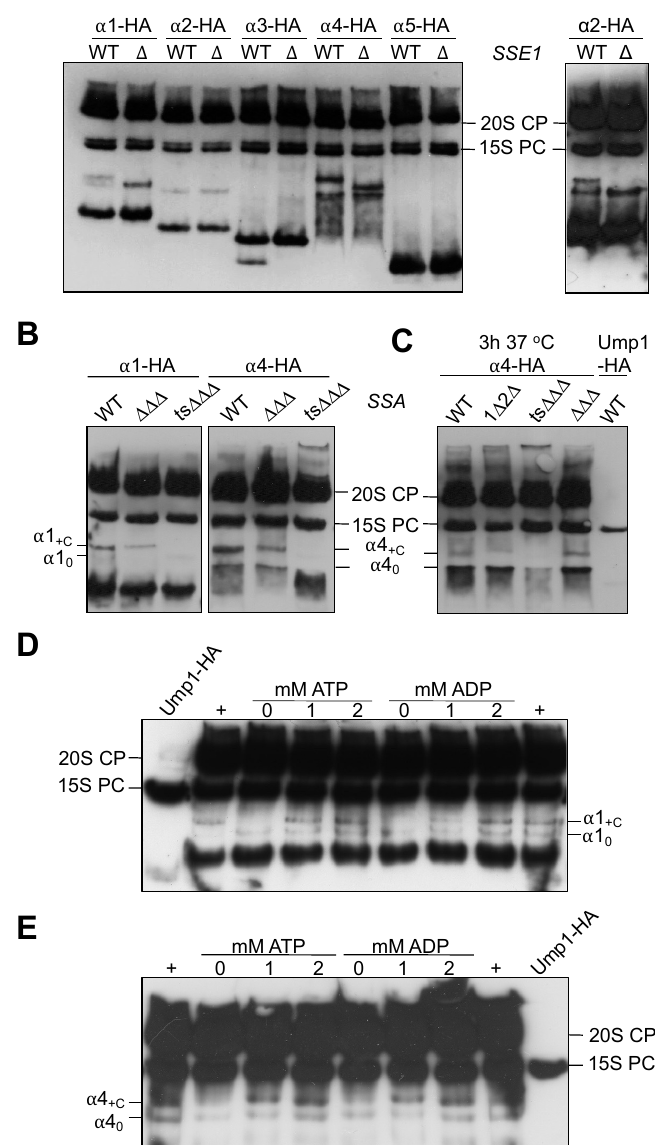
Figure 4. Effects of Hsp70 or Hsp110 mutations and ATP or ADP on early precursors complexes. ( A ) Comparison of the mobility of complexes containing a C-terminally HA-tagged version of the indicated proteasome α subunit in WT and sse1 ∆ by native PAGE. 8 μ g of total protein were loaded per lane. Right panel, analysis of 16 μ g of total protein of the indicated strains expressing α 2-HA. ( B , C ) Influence of Hsp70 mutations on α 1 and α 4 complexes analyzed by native PAGE using the following mutants: ssa1 ∆ ssa2 ∆ ( ∆ 1 ∆ 2); ssa2 ∆ ssa3 ∆ ssa4 ∆ ( ∆∆∆ ); ssa1-ts ssa2 ∆ ssa3 ∆ ssa4 ∆ (ts ∆∆∆ ). In ( C ), the cells were incubated for 3 h at 37 °C. ( D , E ) Cells expressing either α 1-HA ( D ) or α 4-HA ( E ) were subjected to total protein extraction with 26S buffer without ATP (0 mM). Freshly prepared solutions of ATP or ADP were added to aliquots of the extracts to a final concentration of 1 mM and 2 mM as indicated followed by an incubation at room temperature for 30 min. The samples were analyzed by native PAGE and anti-HA immunoblotting. For comparison, extracts of the same strains were prepared in complete 26S buffer containing 2 mM ATP and loaded at the sides